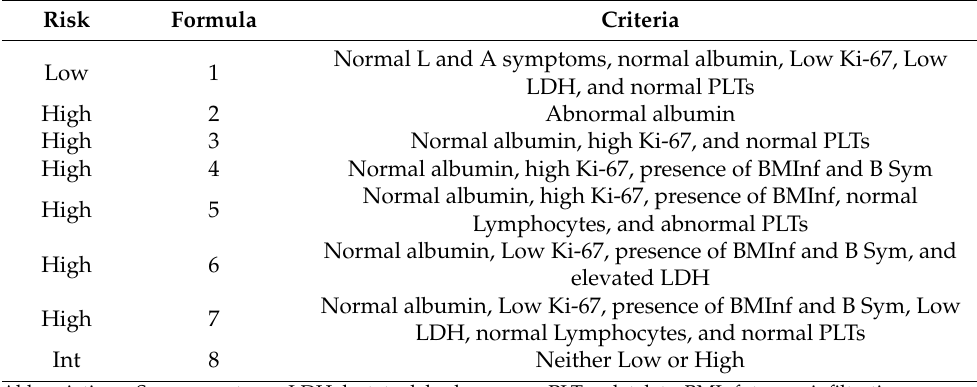
Table 3. Comparisons between the eMIPI distribution and the MIPI-st and MIPI-b distributions in the training data set. MIPI-st